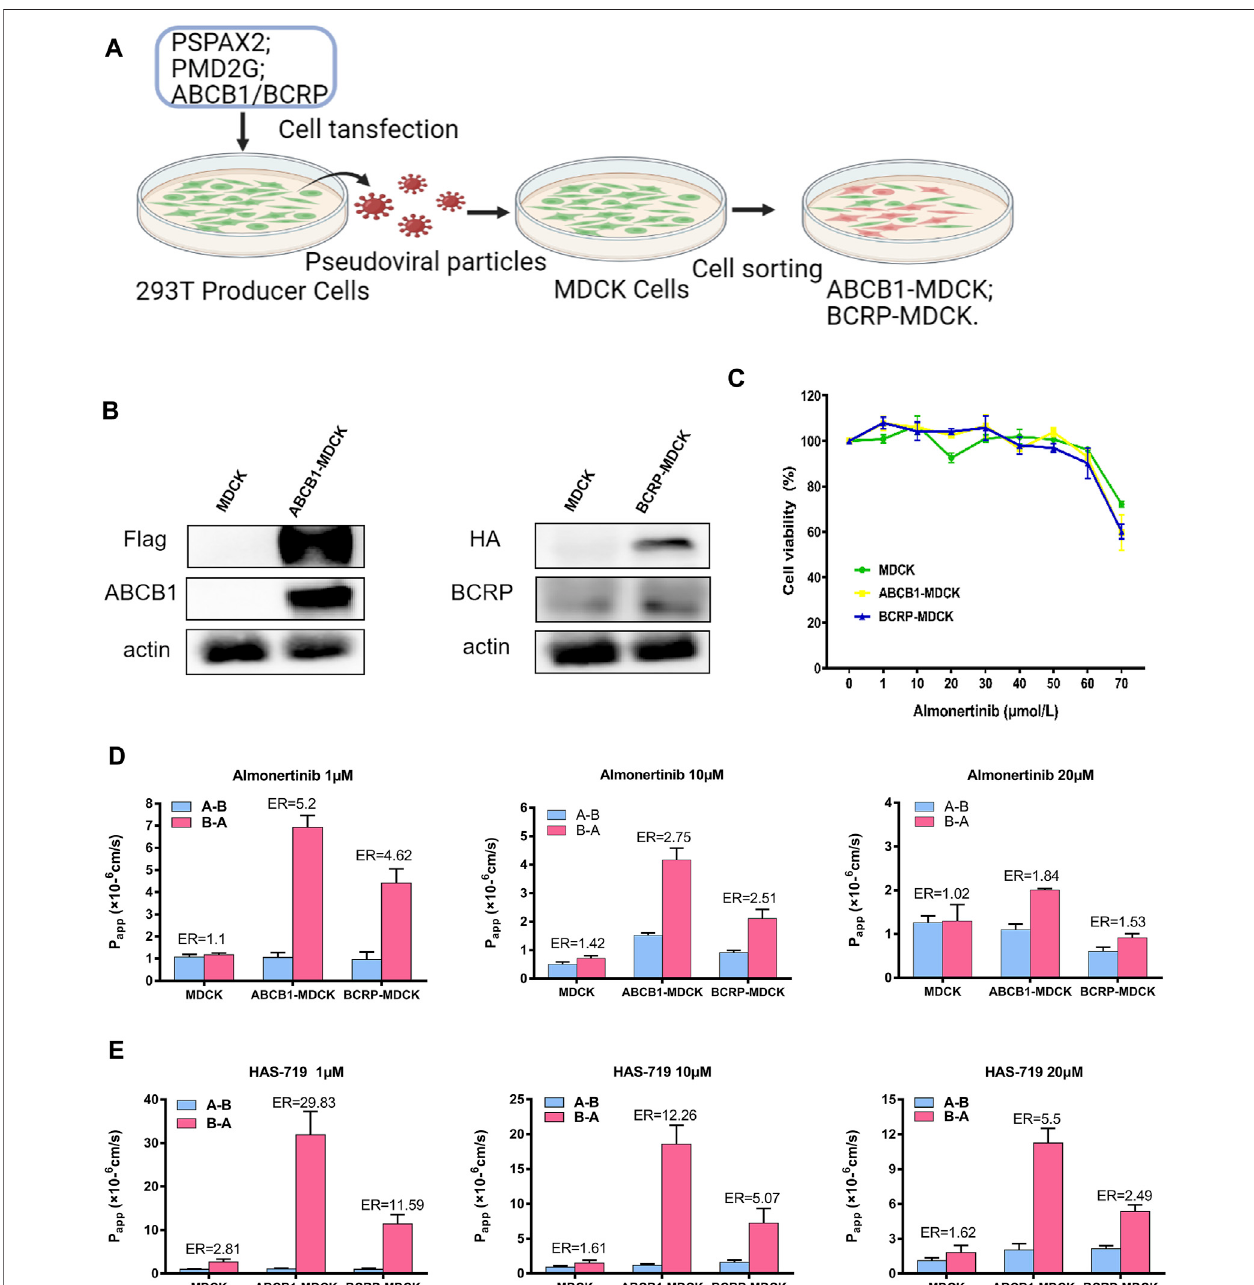
FIGURE 5 | Permeability of almonertinib and HAS-719 across MDCK, ABCB1-MDCK and BCRP-MDCK cell monolayers. (A) The production of ABCB1-MDCK and BCRP-MDCK cells. (B) The ABCB1-overexpressing and BCRP-overexpressing MDCK cells were identi fi ed by western blotting. (C) The effects of almonertinib on the viabilityofMDCK, ABCB1-MDCK,and BCRP-MDCK cells. Thesecellswere treatedwithalmonertinib at agradientconcentration (0 – 70 μ M) for4 h. (D) Permeability of almonertinib (1, 10, and 20 μ M), (E) HAS-719 (1, 10, and 20 μ M) across MDCK, ABCB1-MDCK, and BCRP-MDCK cell monolayers.